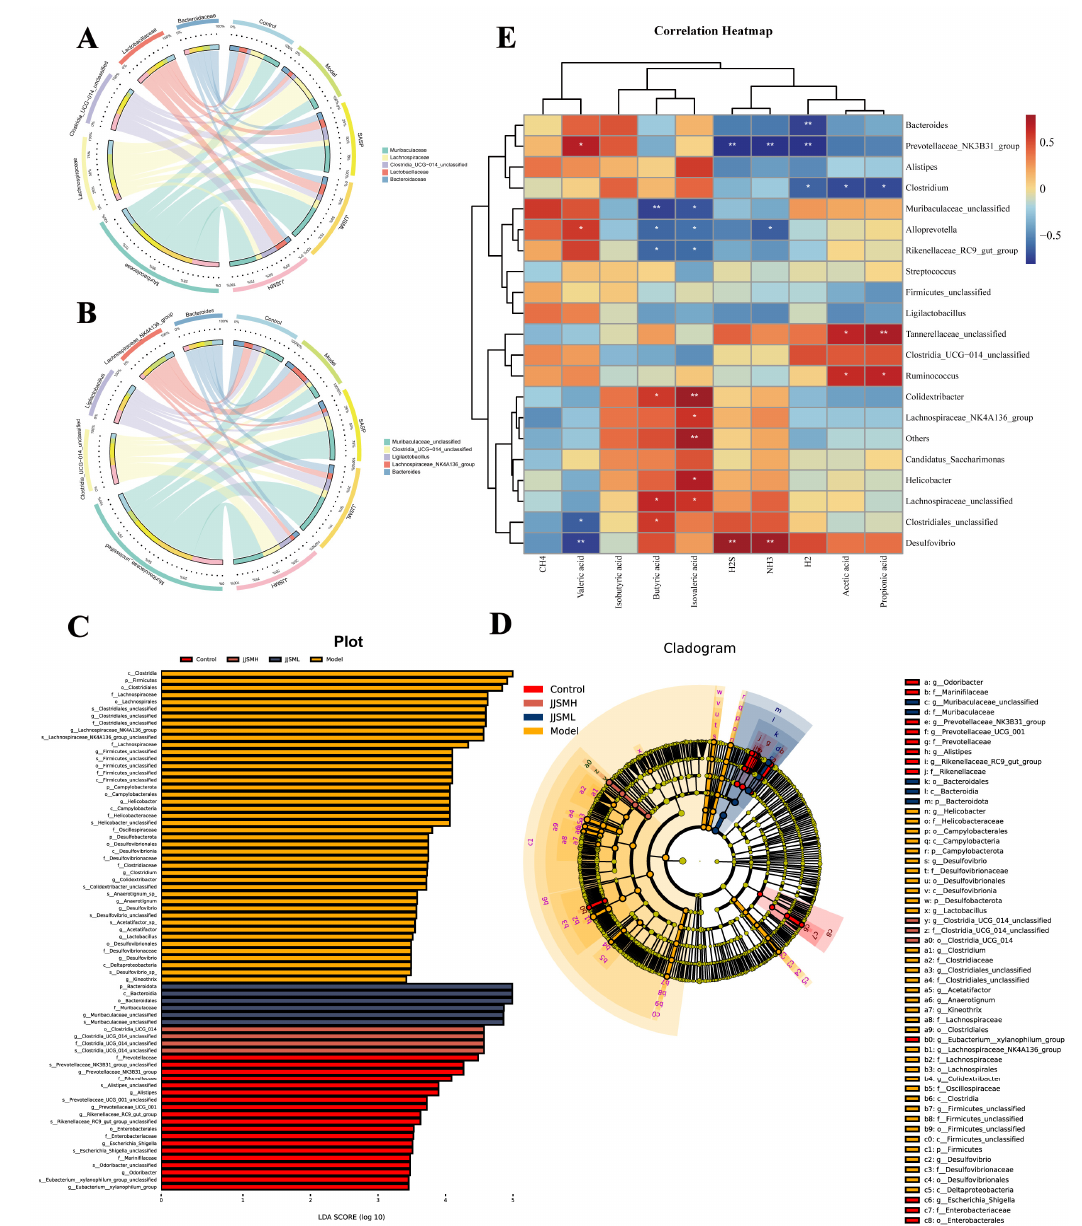
Figure 4. Circos diagram of species-sample relationships (top 5 bacteria). ( A ) At family level; ( B ) At genus level. LDA Effect Size (LEfSe): ( C ) Histogram of linear discriminant analysis (LDA) value distribution. LDA score ≥ 3.5. The length of the bar chart represents the size of the impact of signifi- cantly different species. ( D ) Cladogram. Each node’s size reflects the species’ relative abundance. (phylum = p; class = c; order = o; family = f; genus = g; species = s). ( E ) Microbiota and index correla- tion clustering heat map. Rows indicate species, and columns indicate gas and SCFAs relevant to this study. * p < 0.05, ** p < 0.01. Red indicates a positive correlation, blue indicates a negative corre- lation. The darker the color, the stronger the correlation. The relative abundance of harmful bacteria Clostridiales_unclassified (Figure 3K), Lach- nospiraceae_NK4A136_group (Figure 3L) and Desulfovibrio (Figure 3M) in colitis mice